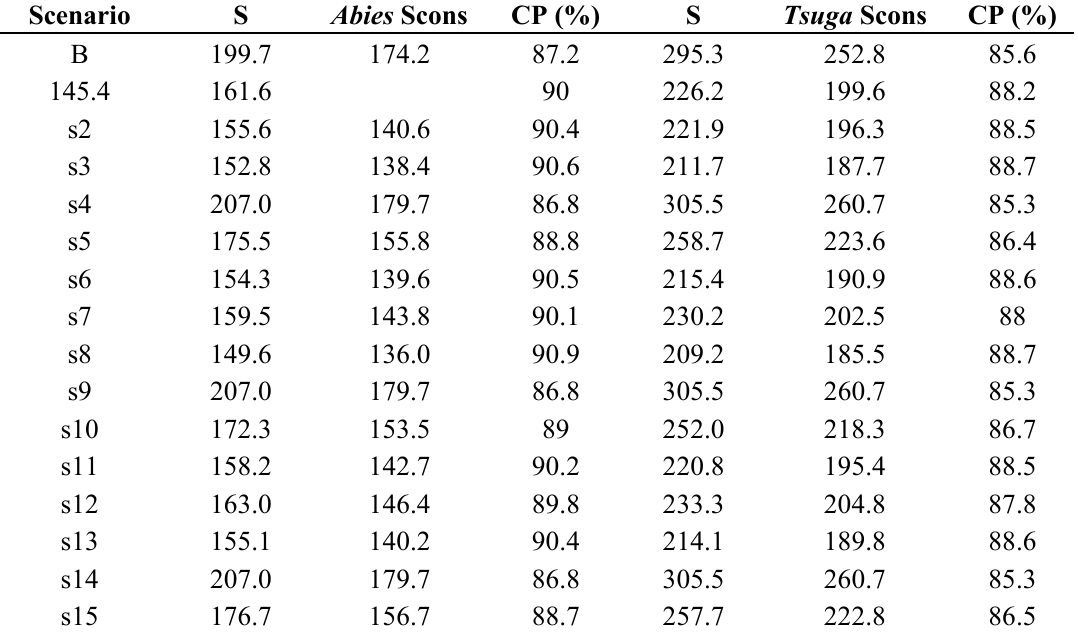
Table 4. Total habitat suitability (S) and habitat suitability within protected areas (Scons) and the proportion of suitable habitat under existing protected areas (CP) under baseline and 15 future climate scenarios (for 2020–2039) for Abies and Tsuga